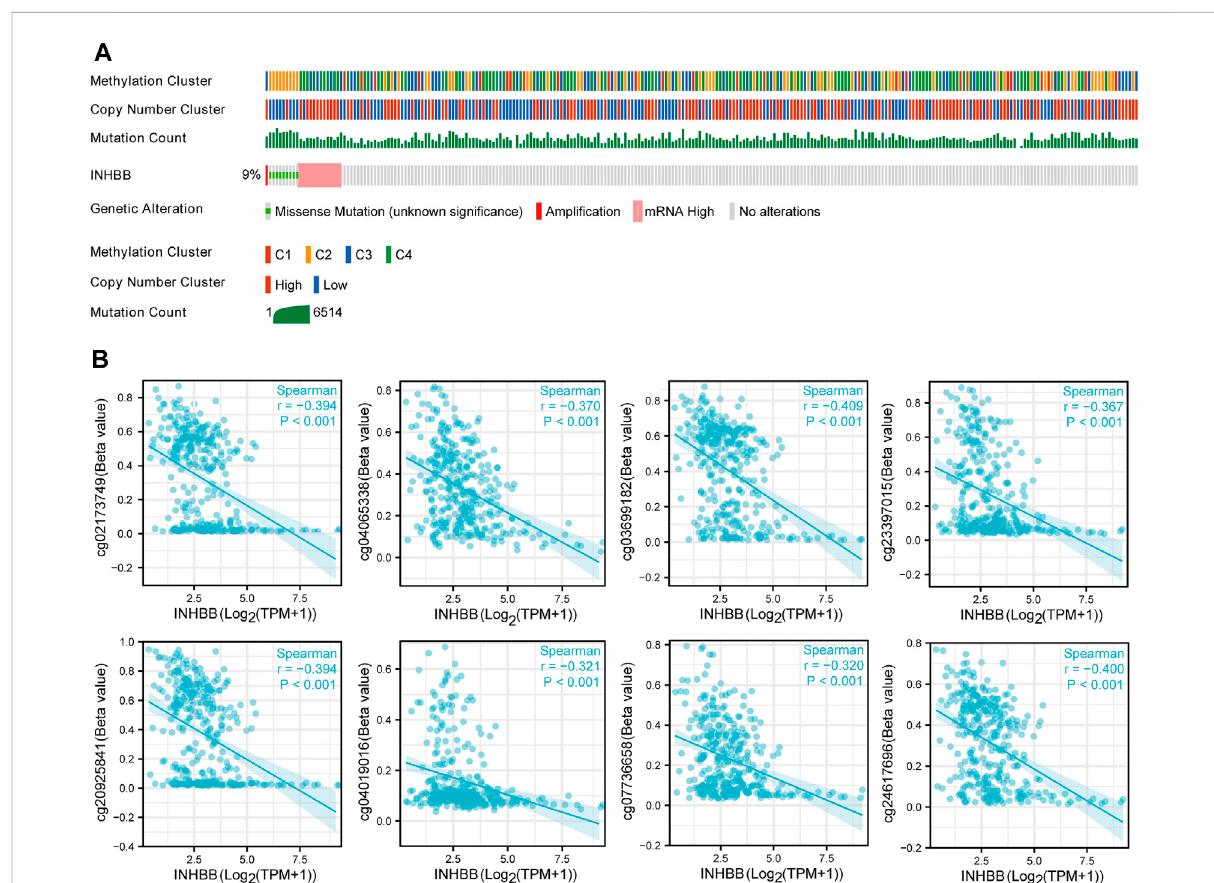
FIGURE 2 The epigenetic changes of INHBB in GC. (A) Genetic alteration of INHBB in GC, (B) Correlation of methylation and INHBB expression in